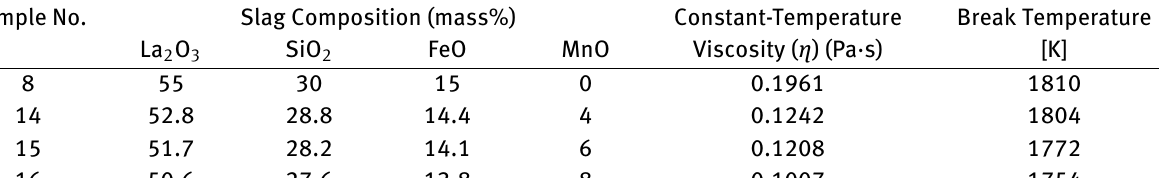
Table 3: Constant-Temperature Viscosity and Break Temperature of La 2 O 3 -SiO 2 -FeO-MnO Slag. Sample No.